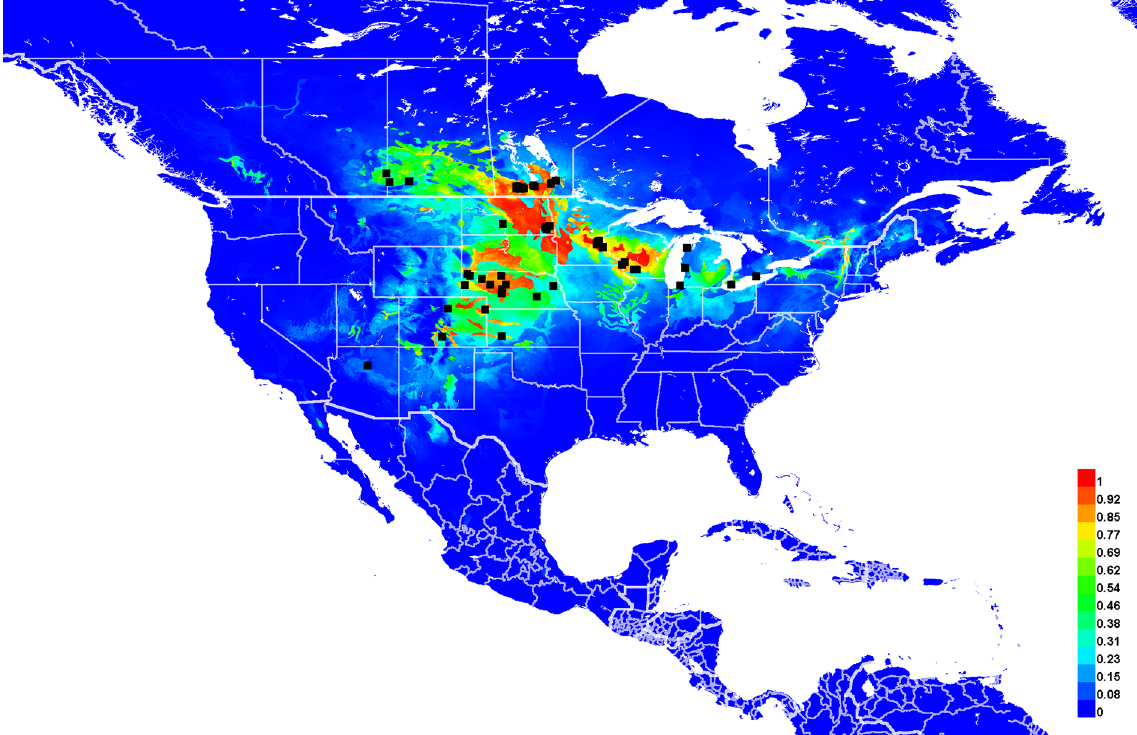
Fig. 74. Georeferenced collection records of Lasioglossum ( D. ) pictum (Crawford, 1902) (black squares) and predicted distribution by maximum entropy ecological niche modeling in Maxent (colour shading). Warmer colours indicate higher cloglog probability of